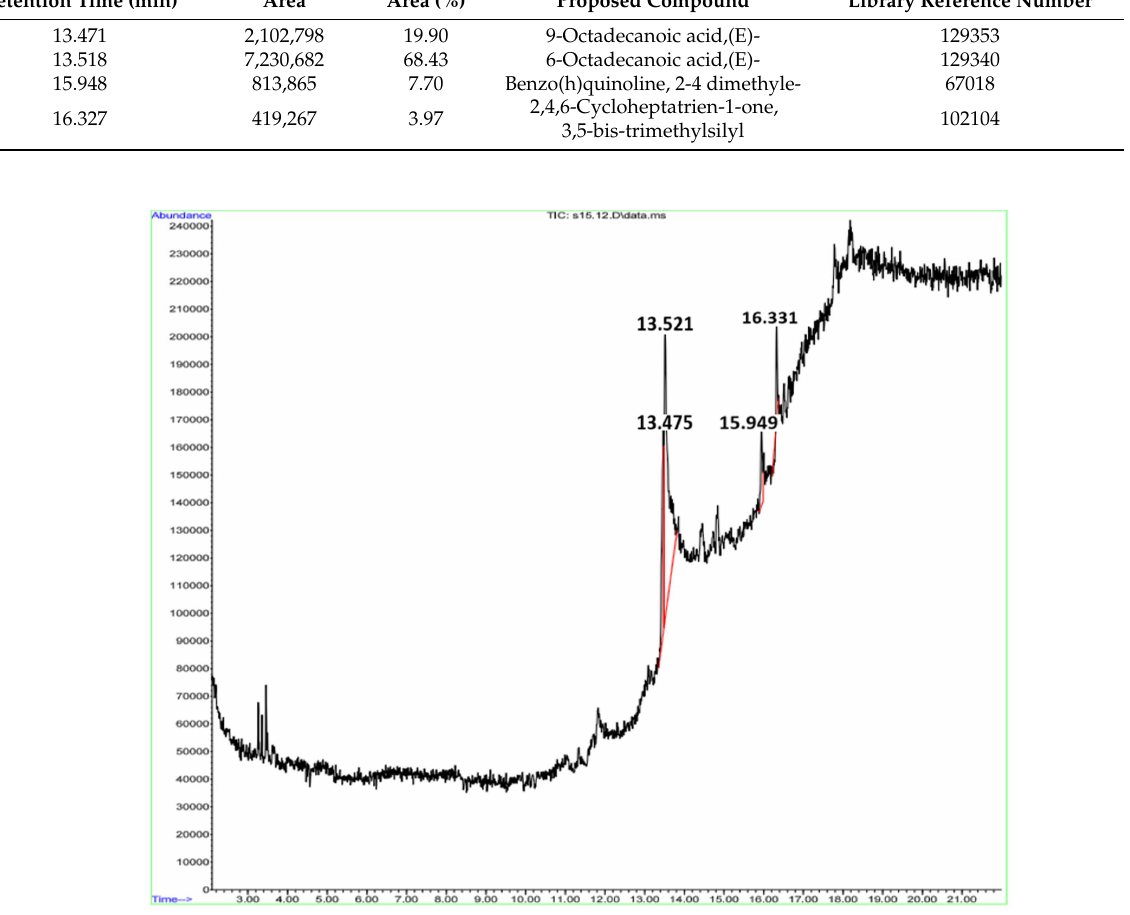
Figure 2. Gas chromatography–mass spectrum of P. costalis foam.